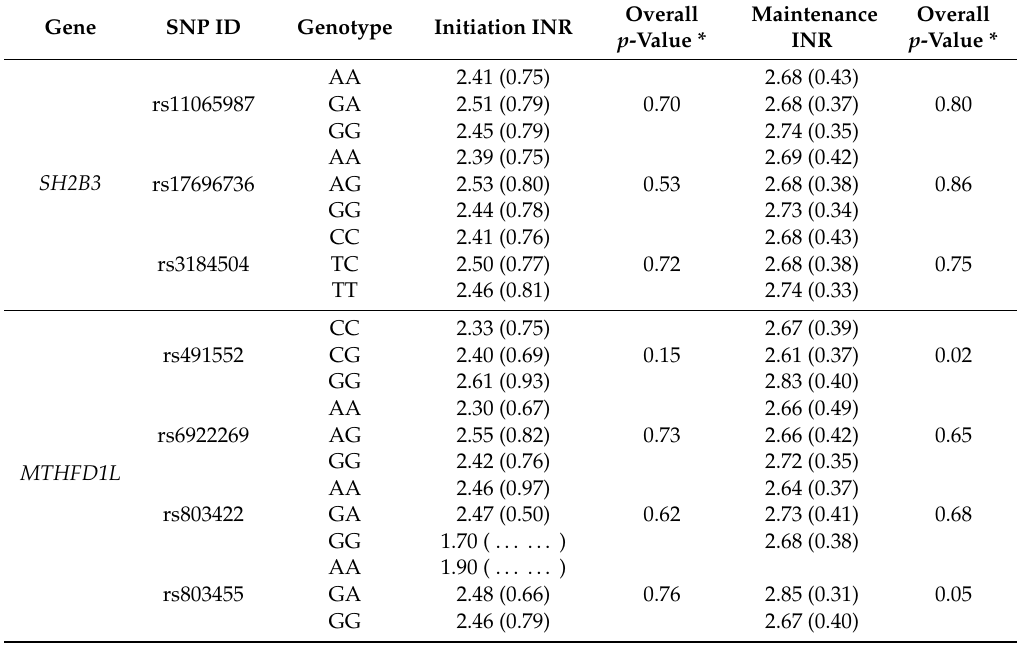
Table 7. Association of SH2B3 and MTHFD1L SNPs with the INR treatment